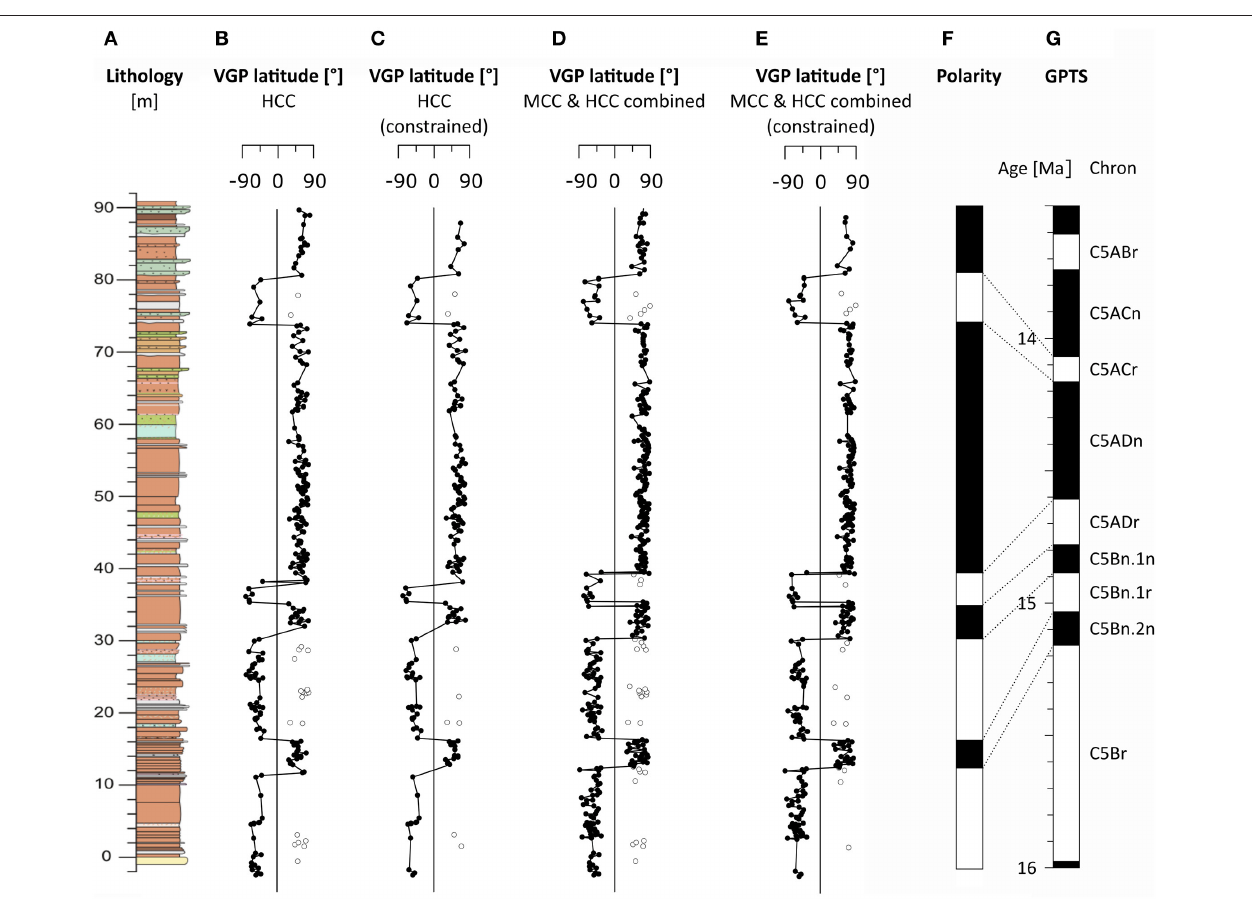
FIGURE 13 | Magnetostratigraphic results for the Bastau Fm based on the rock magnetic data-selection criteria: (A) stratigraphic column (as in Figure 5A ), (B,C) VGP (North poles) latitude plots based on the HCC only and (D,E) based on the MCC & HCC combined data set (selections correspond to Figures 12B,D , respectively), open circles indicate still remaining questionable normal polarity directions within reverse polarity intervals (see text for further explanation), (F) resulting polarity pattern correlated to (G) the GPTS after Gradstein et al.